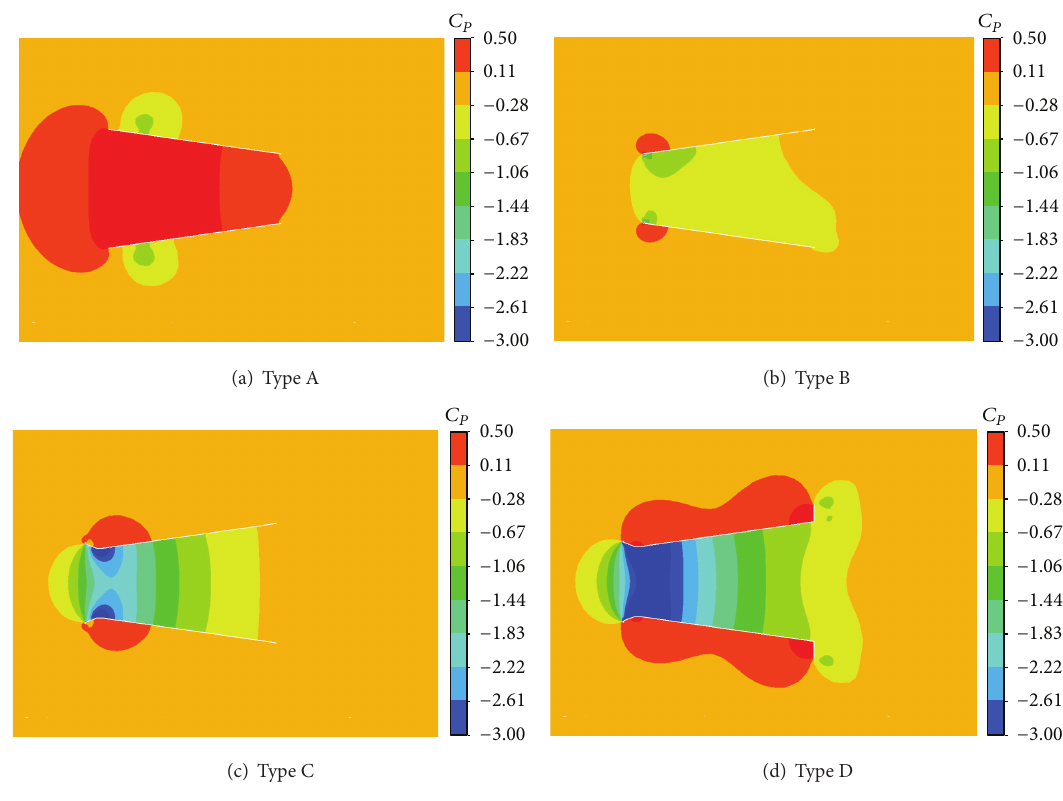
Figure 8: Static pressure